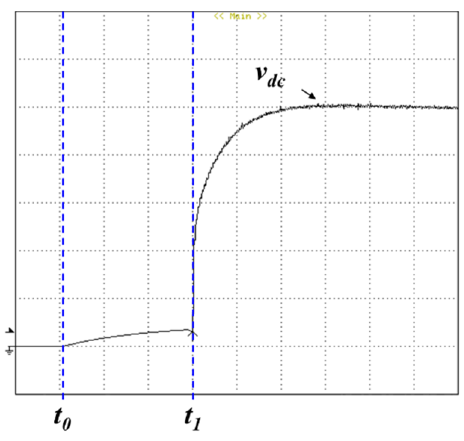
Figure 34. Different stages of the dc-link voltage (voltage: 20 V/div; time: 200 ms/div).